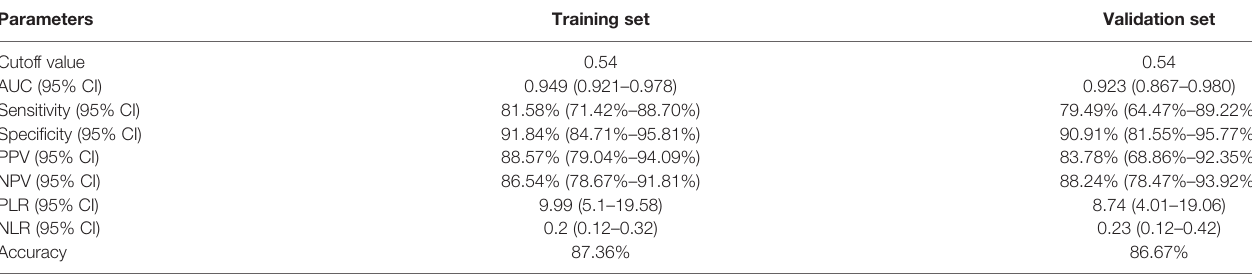
TABLE 4 | The performance of diagnostic model for discriminating TBM from BM.